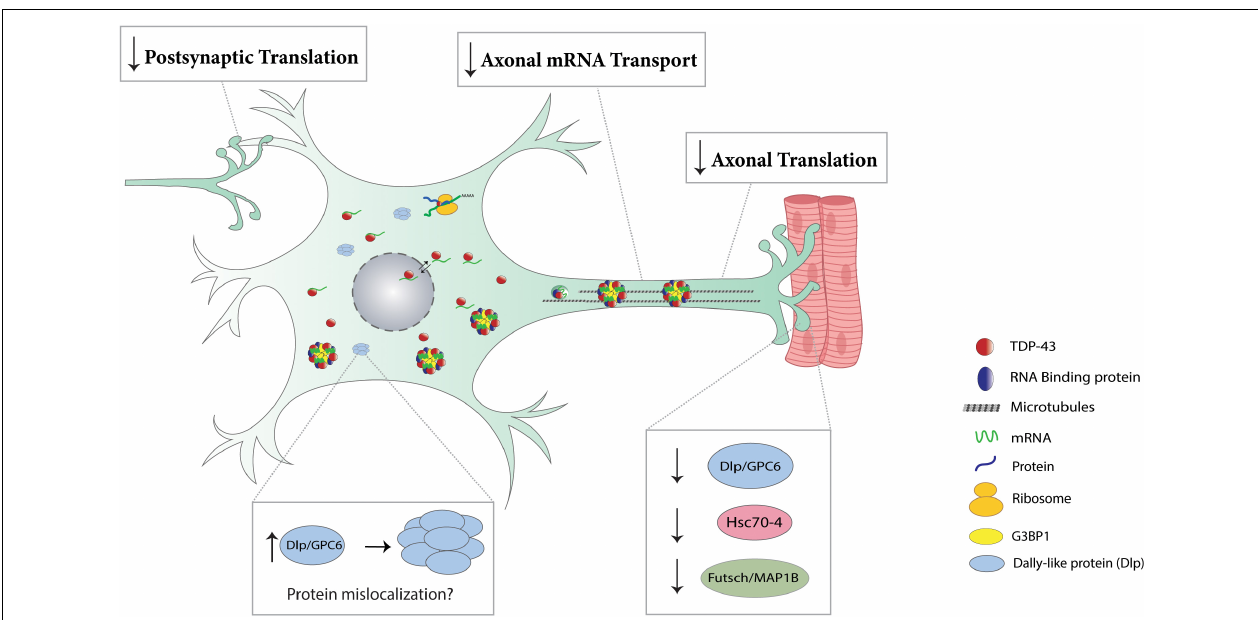
FIGURE 3 | Translation impairments in TDP-43 proteinopathies. Post-synaptically, TDP-43 proteinopathy prevents the dissolution of dendritic RNP granules (Wong et al., 2021), thereby repressing the local translation of key mediators of synaptic plasticity ( Rac1, GluR1, Map1b, CamKII) . Cytoplasmic accumulation of TDP-43 in axons results in the formation of RNP condensates and causes a reduction in local translation of various mRNAs, including ribosomal proteins ( Rp141, Rp126, Rps7) and nuclear encoded mitochondrial proteins ( ATP5A1, Cox4i1, Ndufa4 ) (Nagano et al., 2020; Altman et al., 2021). TDP-43 proteinopathy reduces axonal mRNA transport as evidenced by a reduction in axonal levels of futsch mRNA at the Drosophila NMJ (Coyne et al., 2015). In Drosophila, TDP-43 proteinopathy represses the translation of dlp , futsch/Map1b , and hsc70-4 causing a reduction in respective protein expression at the NMJ (bottom right panel) (Coyne et al., 2015, 2017; Lehmkuhl et al., 2021). TDP-43 proteinopathy causes Dlp/GPC6 protein to accumulate in puncta at the ventral cord neuropil in Drosophila and ALS spinal cords, respectively (bottom left panel) (Lehmkuhl et al.,